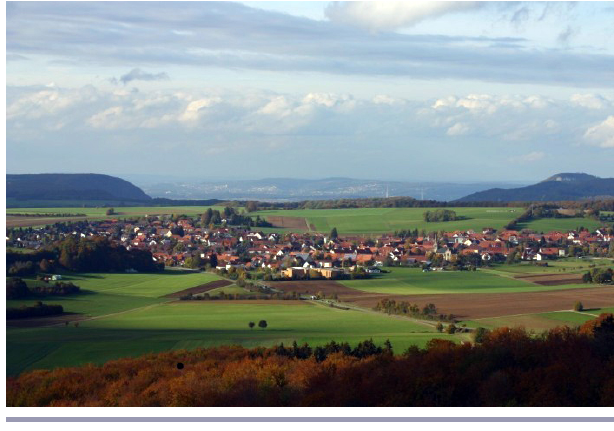
Fig. 3 . Current landscape character in the Römerstein area. Source: Römerstein municipal administration.